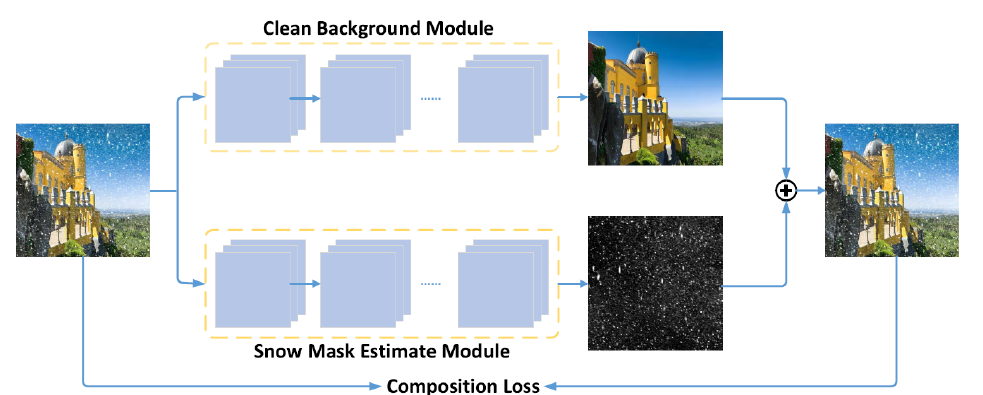
Figure 5. Schematic of the method by Li et al. [106]. A GAN-based architecture learns to extract the clean background image component and the rain streak layer component from an input rainy image by means of the composition loss